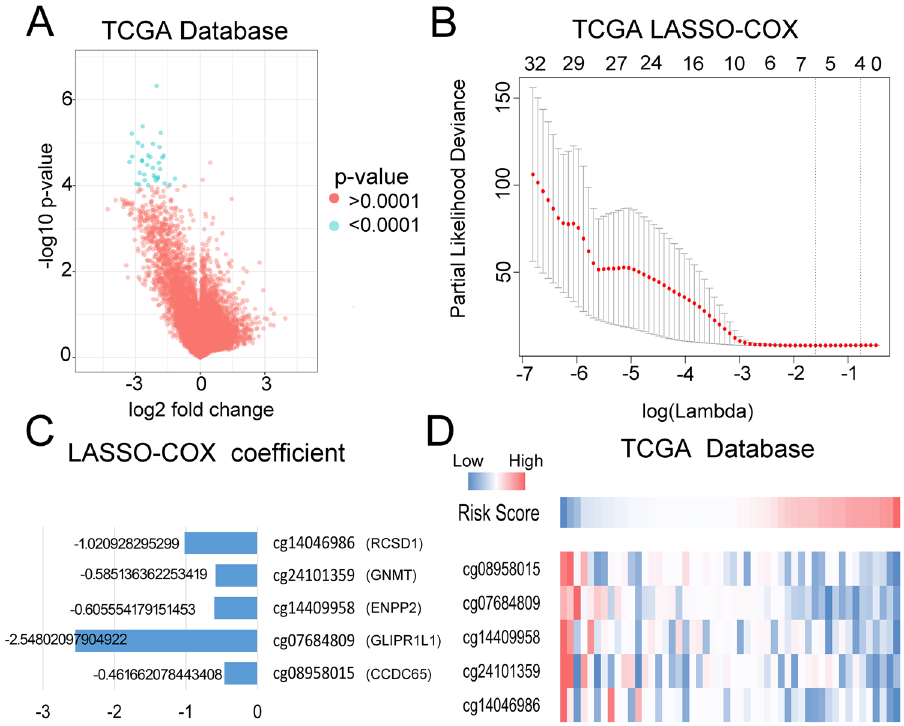
Figure 1. Analysis of methylation using the TCGA database. ( A ) Differentially expressed methylation probes between the radiosensitive and radio-resistant groups. ( B ) Differentially expressed methylation probes determined by LASSO-COX. ( C ) The coefficients of five methylation probes selected by LASSO-COX. ( D ) A novel risk score calculated based on coefficients and the TCGA